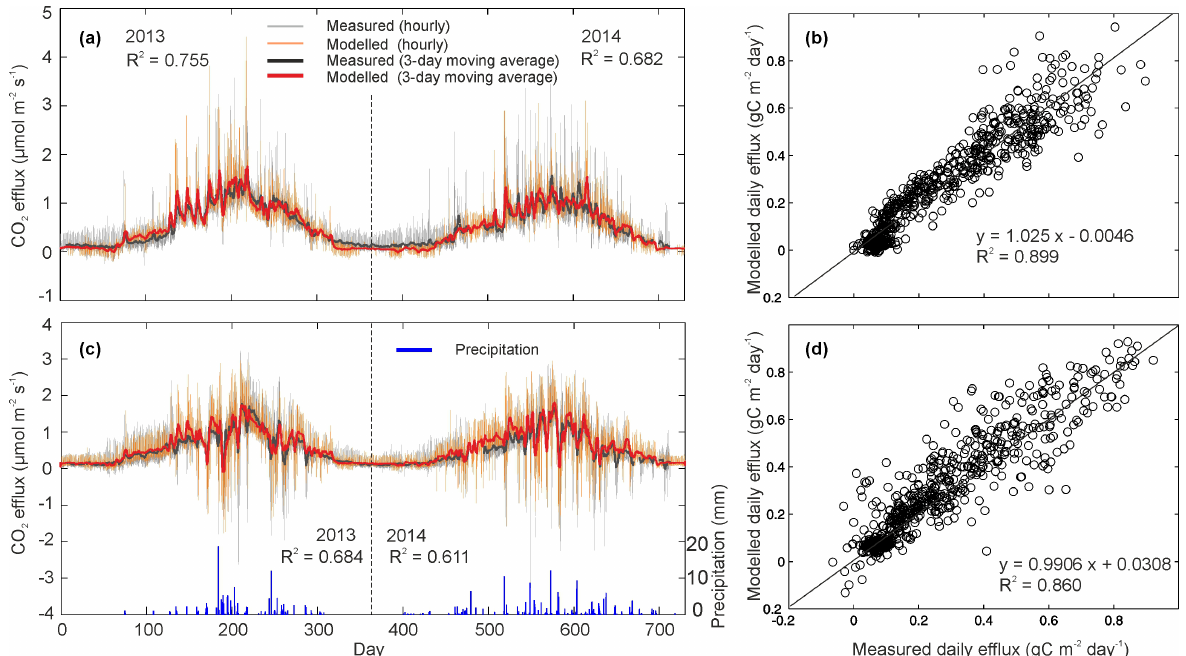
Figure 6. Measured and modelled F S of lichen-crusted soils for opaque (a, c) and transparent chambers (b, d) at hourly (a, b) and daily (c, d) scales during